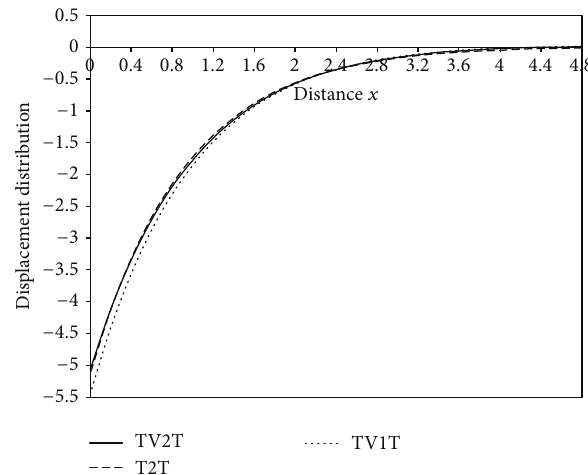
Figure7:Dependenceofthermodynamicaltemperatureonvelocity V of heat source.